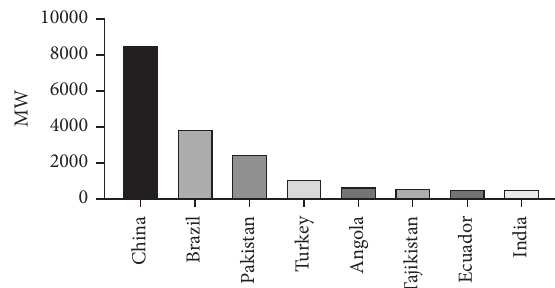
Figure 1: Newly installed capacity by the country, 2018.